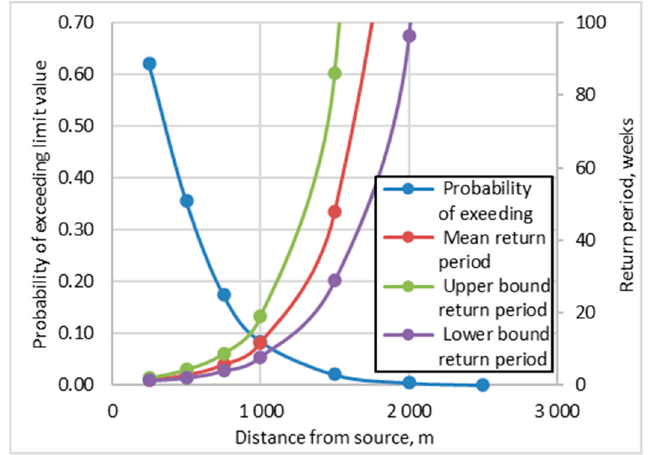
Figure 18. Probability of exceedance of the limit value of 25 µ g/m 3 air pollution concentration of NO x